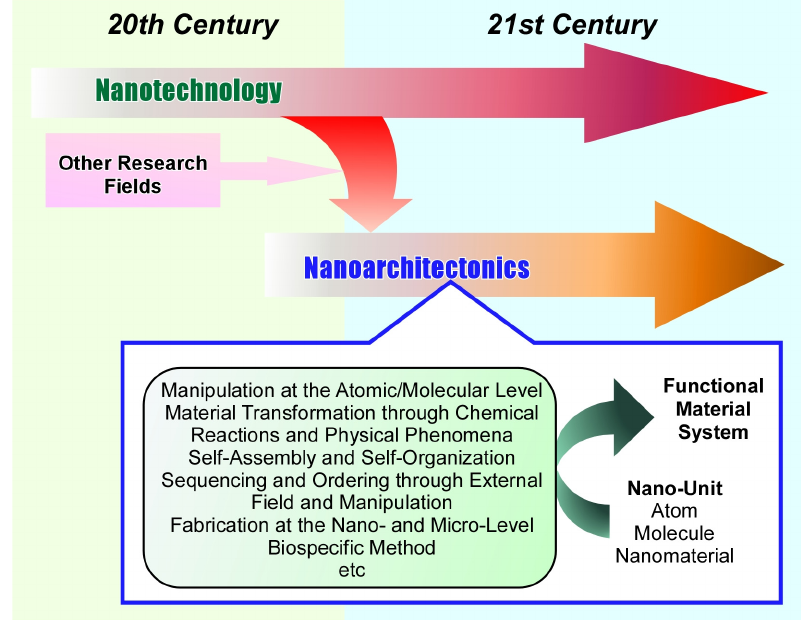
Figure 1. History and outline of the nanoarchitectonics concept.